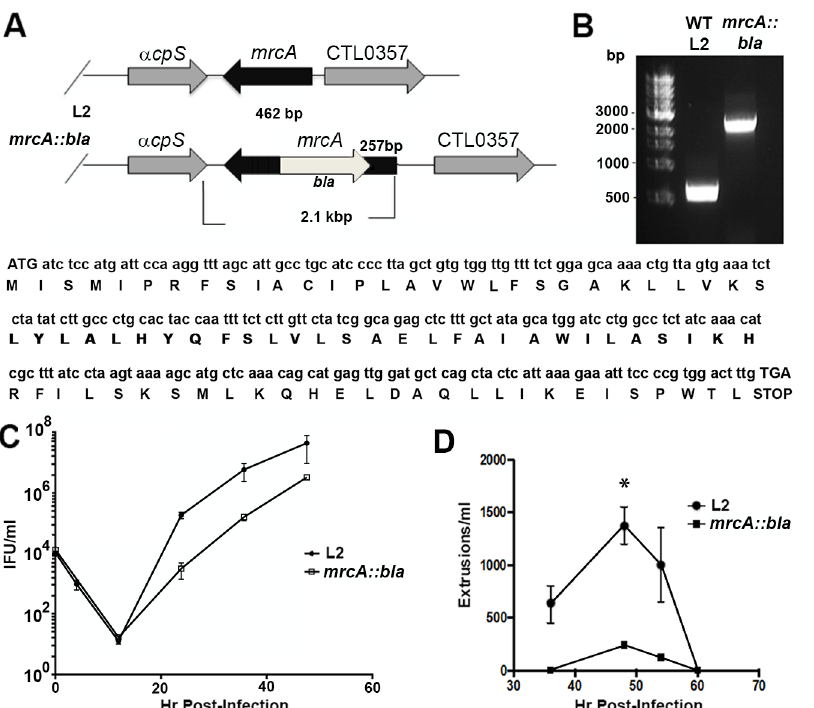
Fig 2. Generation of an mrcA::bla mutant. (A) Sanger sequencing of isolated DNA using gene-specific primers was conducted to verify orientation and insertion of the intron. (B) PCR products were separated on a 1% agarose gel, DNA was visualized using ethidium bromide staining. WT, Wild type. (C) Hela cells infected with wild-type L2 or mrcA::bla L2 were incubated for 0 h, 4 h, 12 h, 24 h, 36 h, or 48h. Cells were lysed in water and replated on fresh monolayers to enumerate the progeny IFUs. Experiments were performed in triplicate (n = 3, error bars indicate SEM. (D) Hela cells infected with wild-type L2 or mrcA::bla L2 at an MOI = 1. At various time points post infection, the supernatants were removed and gently pelleted by centrifugation at 1200rpm. The resulting pellet was resuspended in 100 μ l of media. Extruded inclusions free of host cell nuclei were enumerated (n = 3, error bars represent SEM). The difference was significant (P < 0.01) by an unpaired Students T-test at 48hpi.